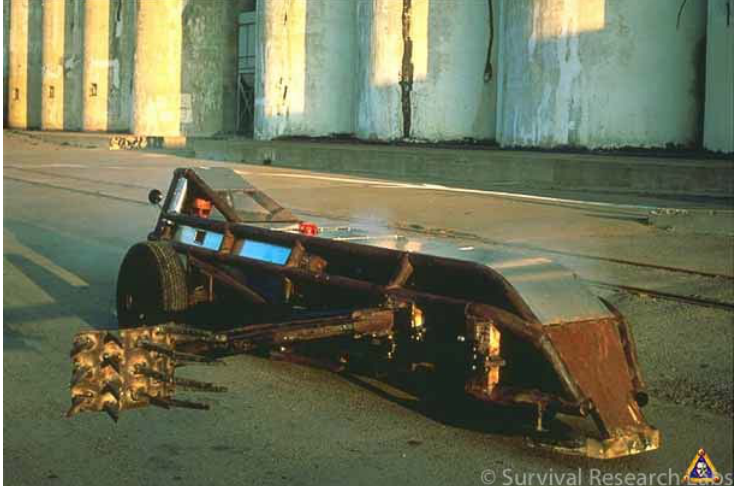
Figure 10. Ram Car by Eric Werner, 1984, San Francisco. © Survival Research Labs. Figure 8. Ram Car by Eric Werner, 1984, San Francisco. © Survival Research Labs